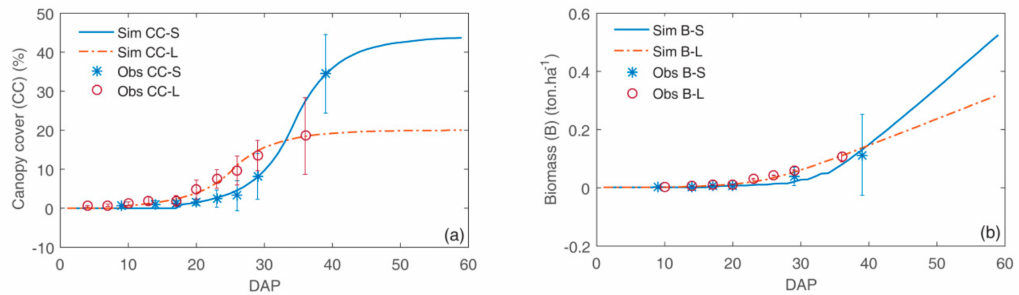
Figure 6. Observed (Obs) data and simulation (Sim) of lettuce growth of AquaCrop: ( a ) canopy cover at site S1 (CC-S) (sand soil) and site S2 (CC-L) (loam soil); ( b ) aboveground biomass at site S1 (B-S) and site S2 (B-S). The error bars were based on 10 biomass samples, except the last observed, which was based on 60 samples at harvest time. Sim CC-S is simulated canopy cover at site S1, Sim CC-L is simulated canopy cover at site S2, Obs CC-S is observed canopy cover at site S1, Obs CC-L is observed canopy cover at site S2, Sim B-S is simulated biomass at site S1, Sim B-L is simulated biomass at site S2, Obs B-S is observed biomass at site S1, Obs B-L is observed biomass at site S2.